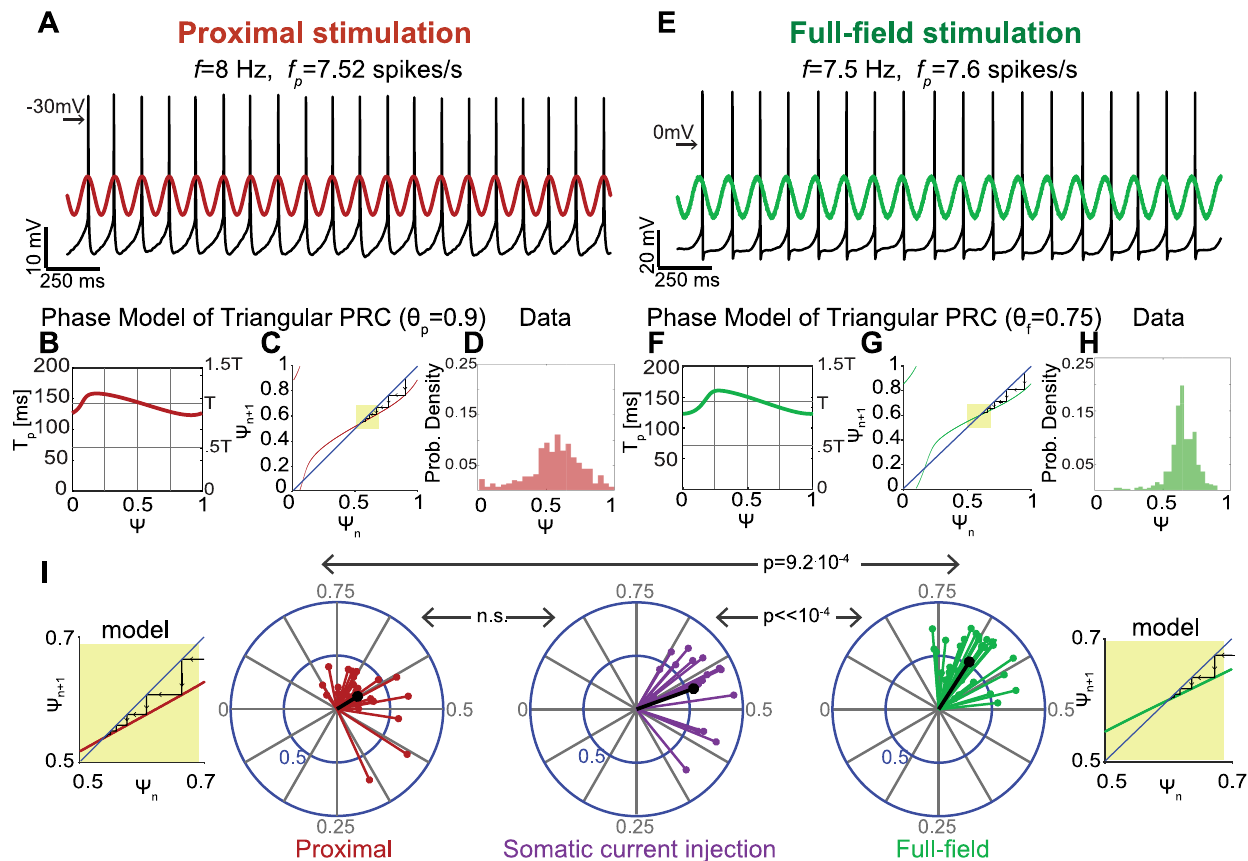
Fig 6. The dendrite impacts the phase of entrainment to rhythmic inputs. A: Perforated patch recording of a spontaneously spiking neuron with an average perturbed firing rate f . A cosine shaped stimulation delivered in the proximal illumination condition entrained the discharge of the cell. The spike p tends to occur near the peak of the stimulation, corresponding to phases near 0.5. Left arrow indicates -30 mV. B: Simulated (Eq 5) plot of the perturbed period ( T ) as a function of the effective phase of the preceding spike (for θ = 0.9). C: Iterative map of ψ versus ψ generated based on the simulated plot p p n+1 n shown in B. The map (red) crosses the diagonal (blue), achieving a stable fixed point at phase 0.537, as demonstrated by the Cobweb plot (black arrows). Yellow box highlights stable fixed point. D: The probability distribution of effective phases shows a peak at approximately 0.5, in accordance with the raw data shown in A. E: Same as A for full-field illumination. Spikes occur slightly after peak of cosine stimulation. Left arrow indicates 0 mV. F: Same as B for full- field illumination (for θ f = 0.75). G: Same as C for full-field illumination. The map (green) crosses the diagonal (blue), generating a stable fixed point at phase 0.6. Phase locking induced by full-field stimulation occurs at a delayed phase compared to proximal stimulation (shown in A-D). H: Same as D for full-field illumination. The phase of the peak in the probability distribution is later than that corresponding to proximal illumination and shown in D. I: Distribution of circular variances of effective phases (each calculated from a corresponding probability distribution of effective phases as in panels D and H) for various stimulation frequencies (2.5-21Hz) in n = 6 cells, under three stimulation conditions: proximal illumination (red), somatic current injection (purple) and full- field illumination (green). Mean vectors are shown in black. Proximal illumination and somatic current injection induce locking in a similar range of phases, but current injection is more effective in entraining the neuron’s spiking. Phase locking generated by full-field illumination is shifted rightward compared to proximal illumination and current injection by 0.072–0.104. Yellow insets are zoomed-in versions of panels C and G that show that the shift in the model of the empirical distribution of locked phases agrees with the phase model simulations. See Materials and Methods for derivation of P-values.